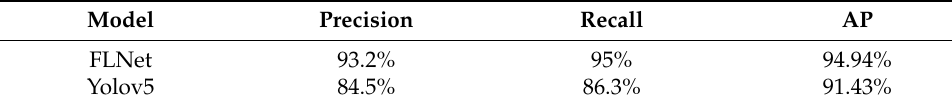
Figure 14. Comparison of the P–R curves of the two detection algorithms on HRSID: ( a ) P-R curve of YOLO V5 on HRSID dataset; ( b ) P-R curve of FLNet on HRSID dataset.